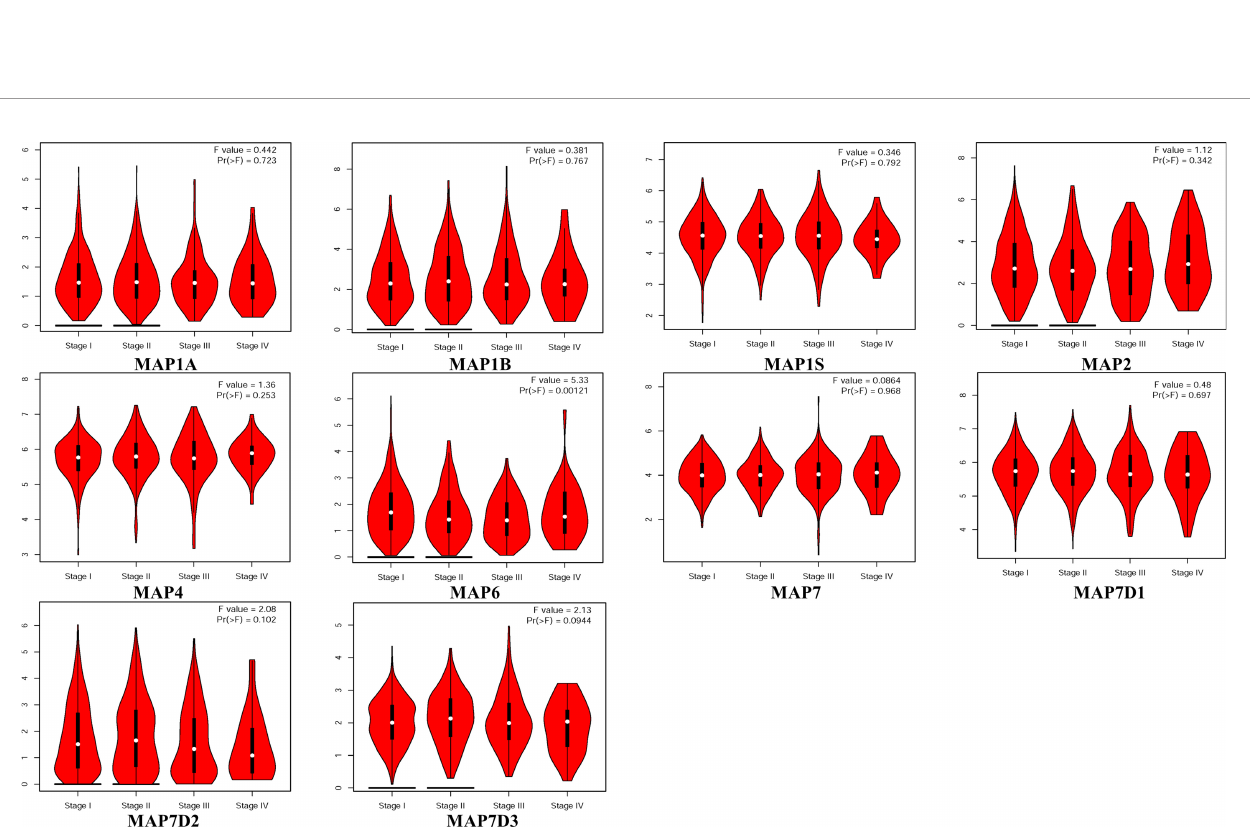
FIGURE 3 | Correlation between MAP expression and cancer stage in NSCLC (GEPIA). GEPIA, Gene Expression Pro fi ling Interactive Analysis; MAP, microtubule- associated protein; NSCLC, non-small cell lung